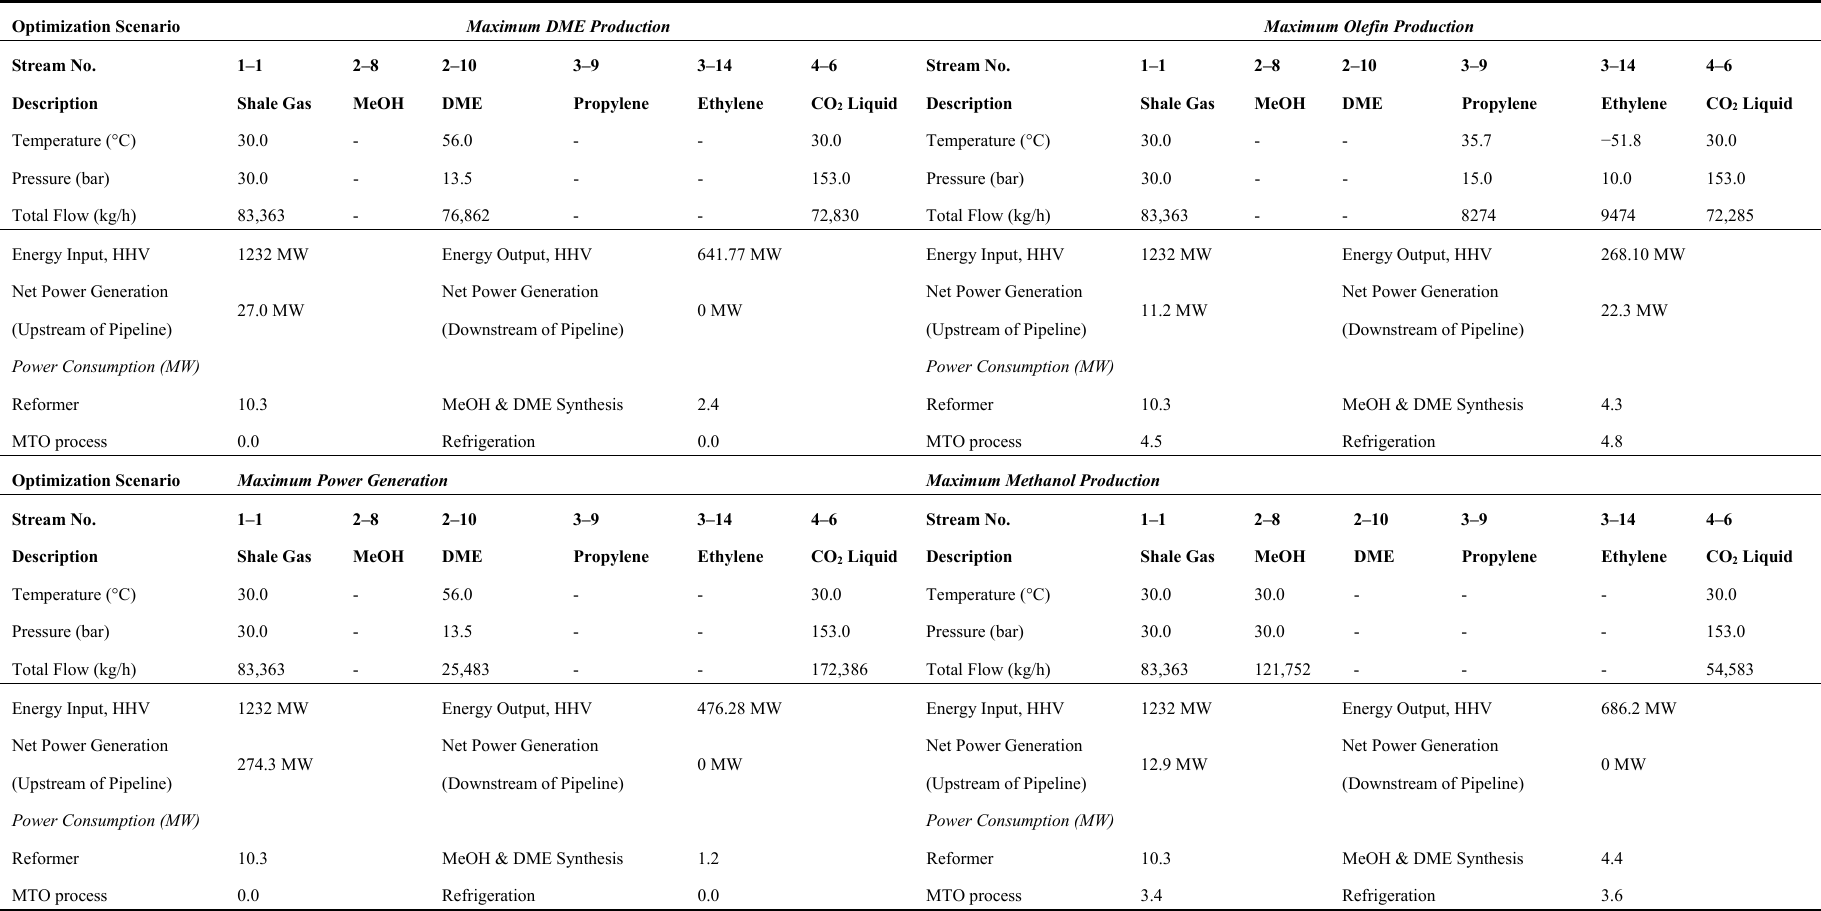
Table 6. Selected results of four different process scenarios (Fayetteville shale gas). The energy output is defined as the electricity produced plus the higher heating values of methanol, DME and olefins